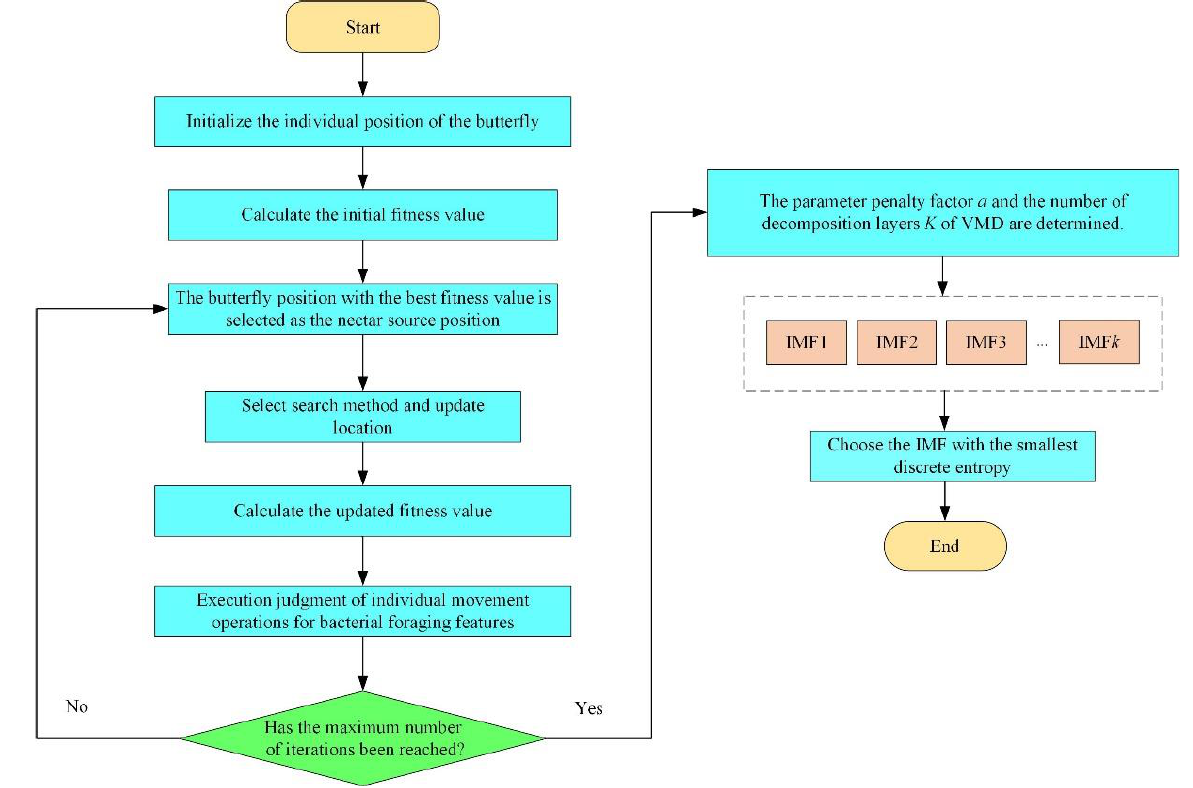
Figure 2. The optimization process of VMD parameter values.